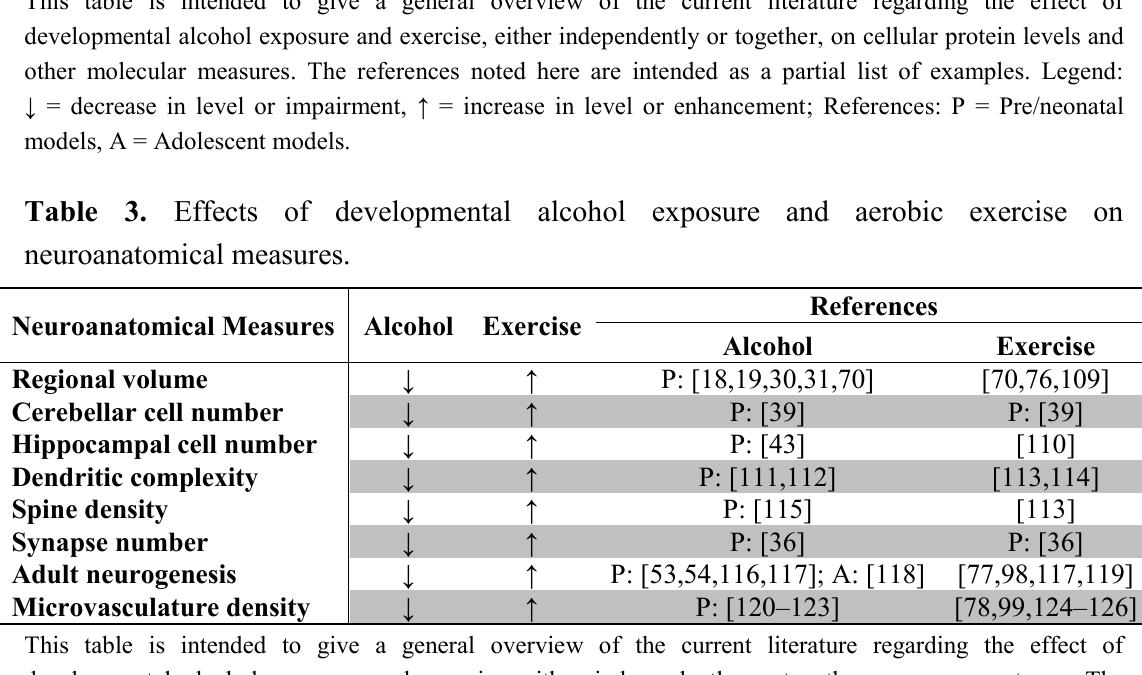
Table 2. Effects of developmental alcohol exposure and aerobic exercise on molecular measures. Molecular Measures